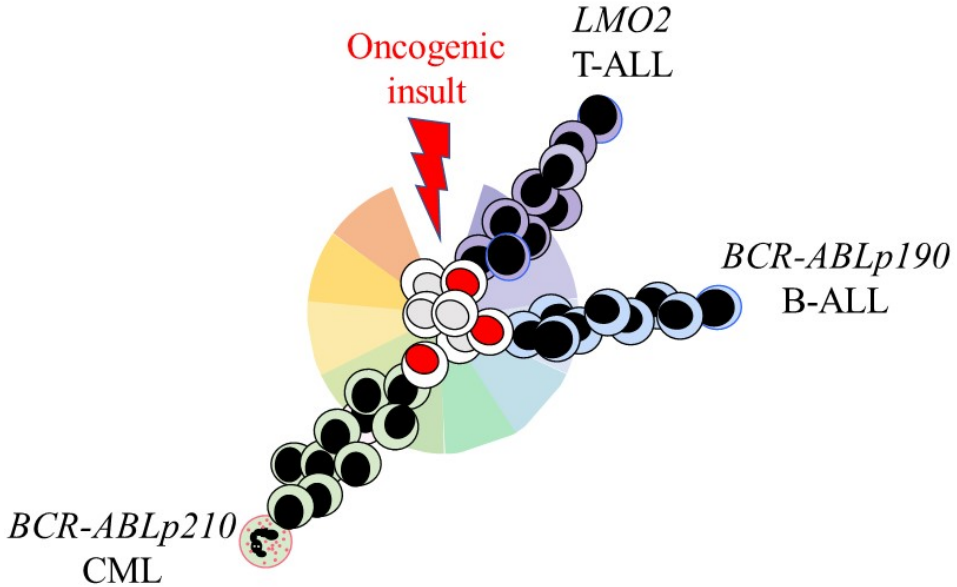
Figure 2. Some oncogenes set the lineage fate of LSCs and their offspring. Expression of the oncogenes BCR-ABLp210 , BCR-ABLp190 , and LMO2 was restricted to hematopoietic stem and progenitor cells in transgenic mice by means of the Sca1 promoter. This led to the development of myeloid, B-cell, and T-cell leukemia.